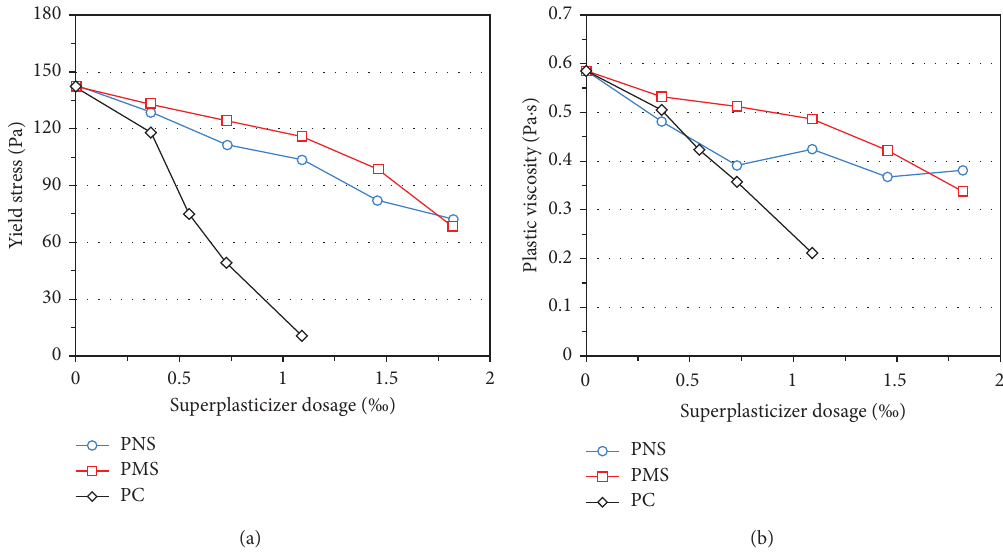
Figure 7: Effects of superplasticizer types and dosages on the development of (a) yield stress and (b) plastic viscosity of